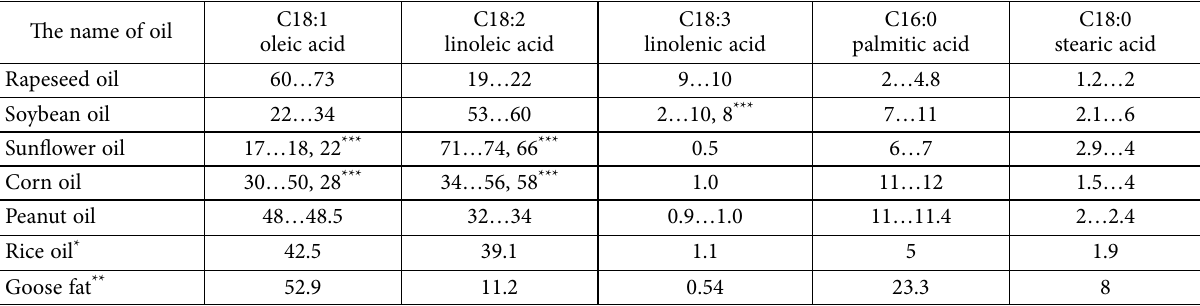
Table 1. The content of the fatty acids in vegetable oils (Baczewski, Kałdoński 2008) and goose fat [% of mass] The name of